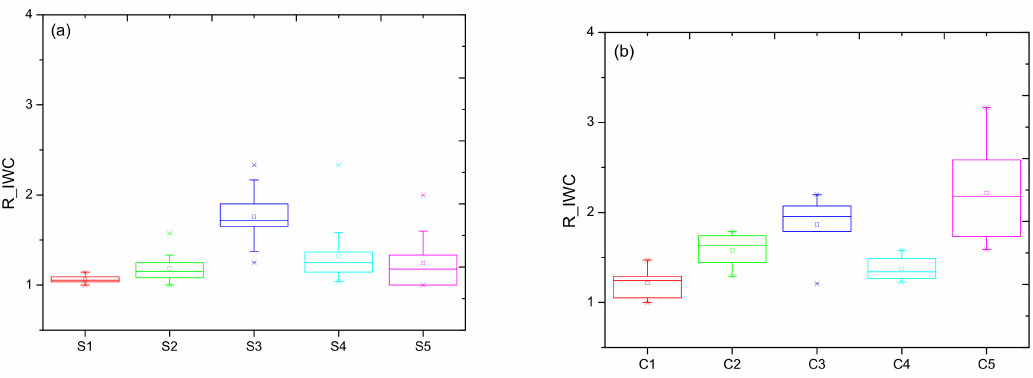
Figure 8. Statistics of R _ IWC in the selected region: ( a ) stratiform; ( b ) convective.